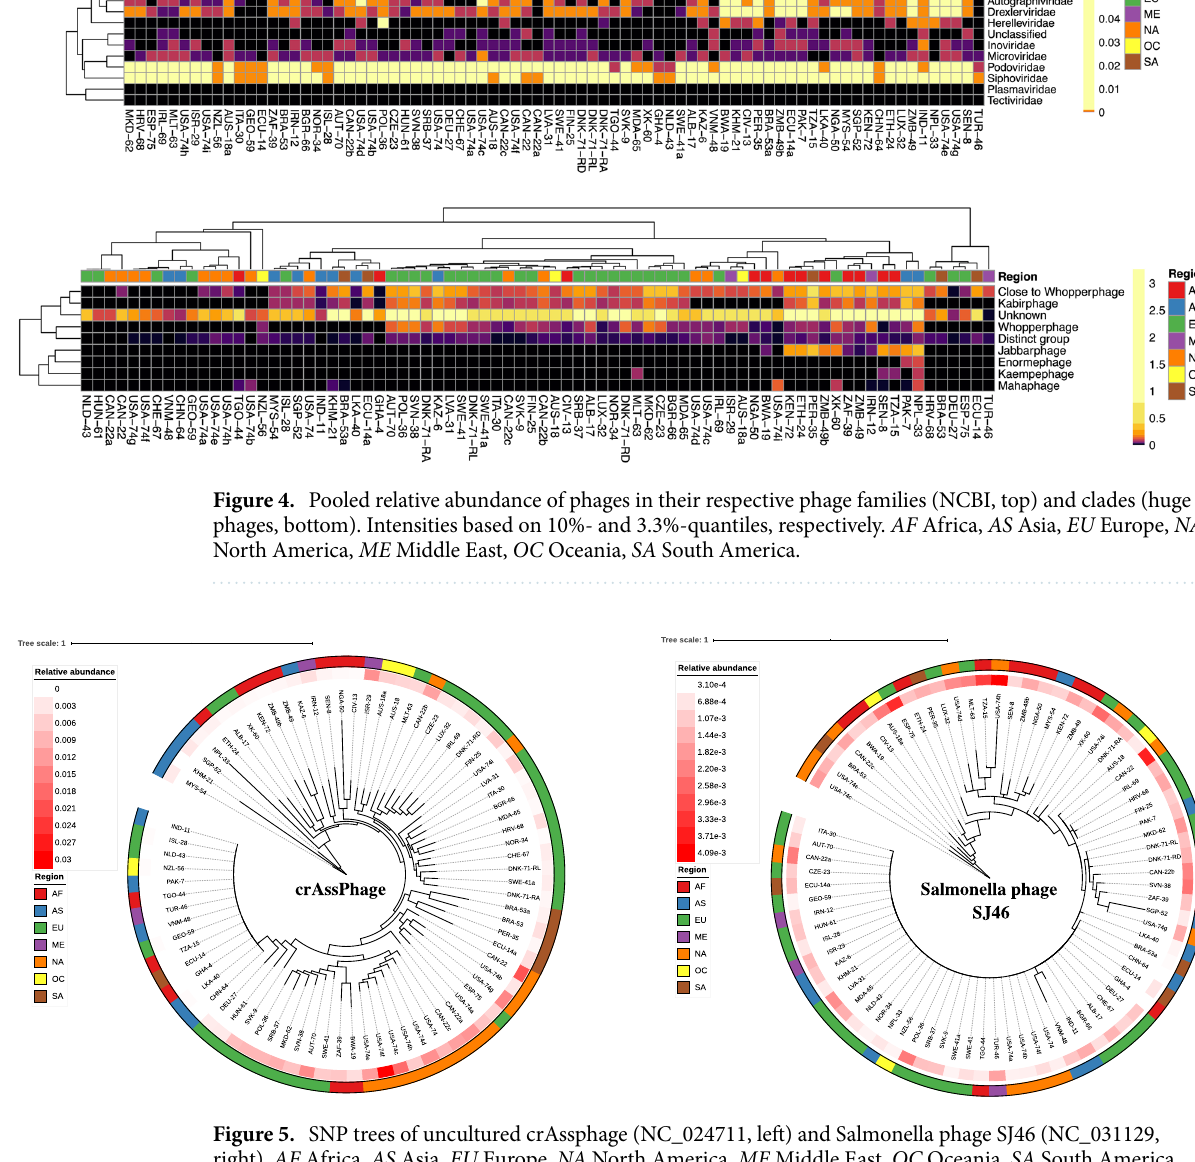
in Europe, North America, Oceania and Middle East. In contrast, macrolide, macrolide combination (Macro/ Linco/StreptoB) and β-lactam resistance were more globally distributed, though with a slightly higher abun- dance in the former regions. With regards to the Functional Resistance database (Fig S11 bottom), the most common resistance classes were those conferring resistance towards the compounds of cefoxitin (cephalosporin; β-lactam), trimethoprim (antifolate), piperacillin (β-lactam), amoxicillin (β-lactam), and tetracycline (tetracy- cline), with penicillin (β-lactam), chloramphenicol (chloramphenicol) and co- trimoxazole (sulphonamide) and D. cycloserine (d-alanine analogue) being less abundant. No single region showed a greater degree of resistance to any one class, in contrast to the findings of ResFinder. Bacterial occurrence. The most abundant bacterial genera across most regions appeared to be Acinetobac- ter, Acidovorax, and Cupriavidus (Fig S12). A large cluster was apparent in the European and North American regions, which also largely clustered together, except for a few countries which interspersed with Africa, Asia and South America in smaller clusters. Neither the Middle East nor Oceania showed any degree of clustering. The Lactococcus bacterial genus was, surprisingly, only present in low abundance in the countries where Lactococcal phages were represented (Fig S8), i.e. Slovakia (SVK-9), Sweden (SWE-41) and Latvia (LVA-31).